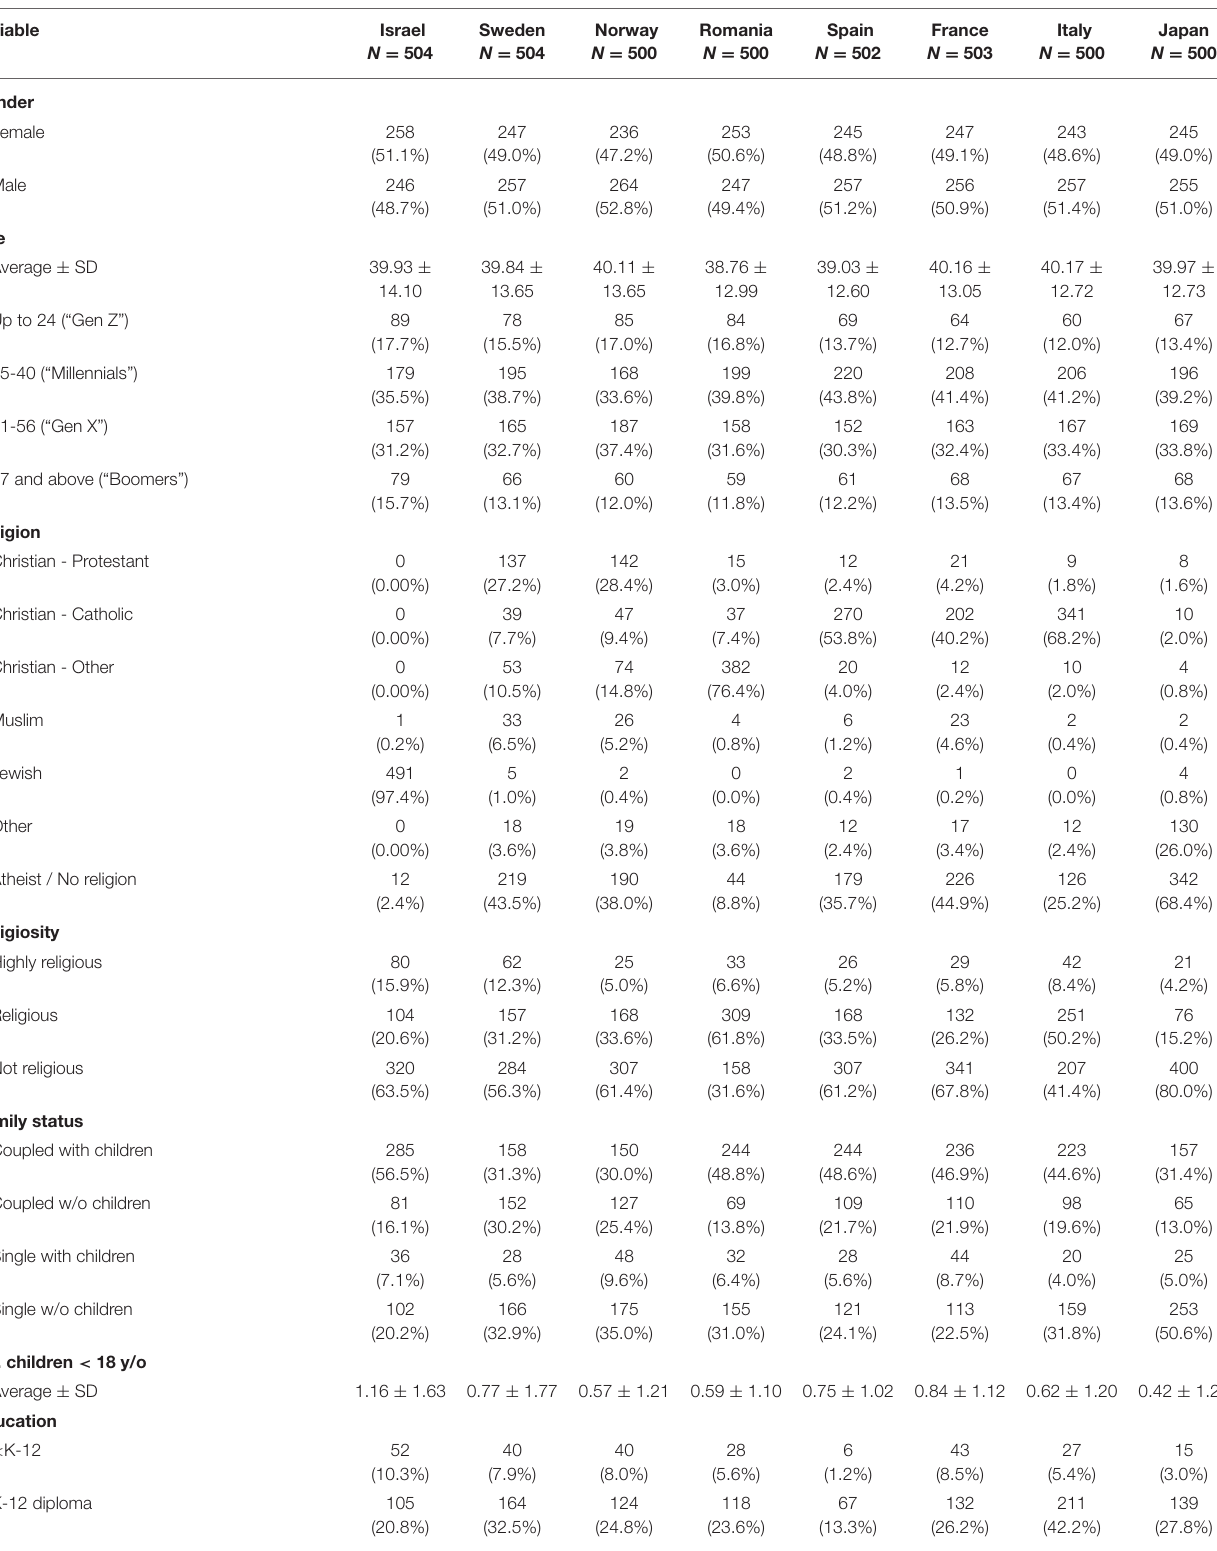
TABLE 1 | Socio-demographic breakdown of the studied sample ( N = 4,013).